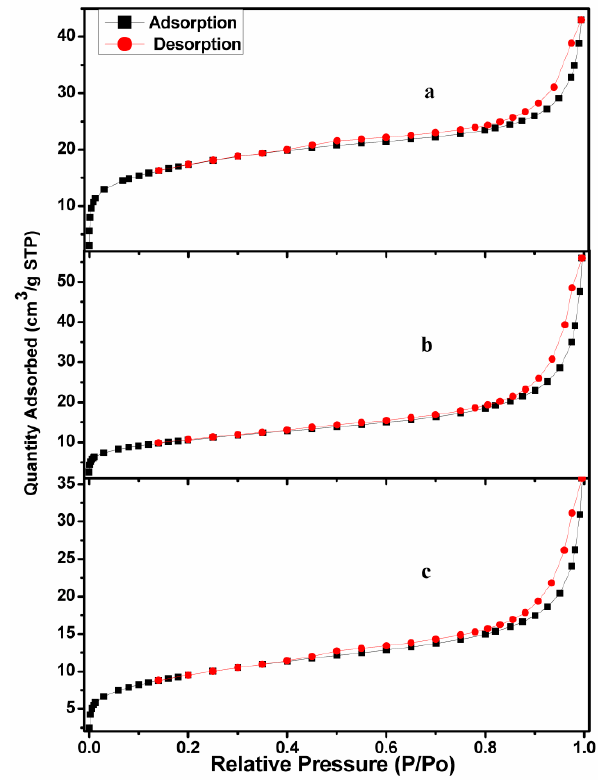
Figure 3. N 2 adsorption–desorption isotherms at 77 K for representative catalysts ( a ) HT, ( b ) 5%Pt– 0%Bi/HT, ( c )